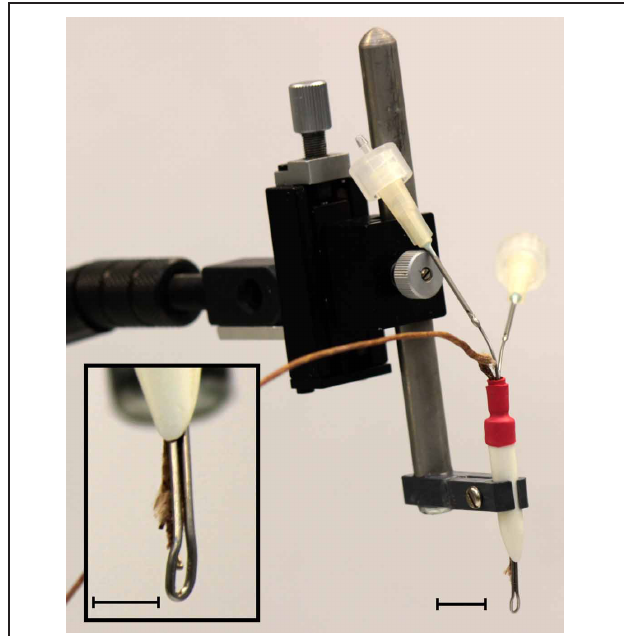
FIGURE 1 | Photograph of the cryoloop used to cool the IC held in a micromanipulator. Two 19 gauge needles soldered to each end of the stainless steel cryoloop tubing acted as the inlet and outlet ports for the coolant. The manipulator allowed precise placement of the loop in